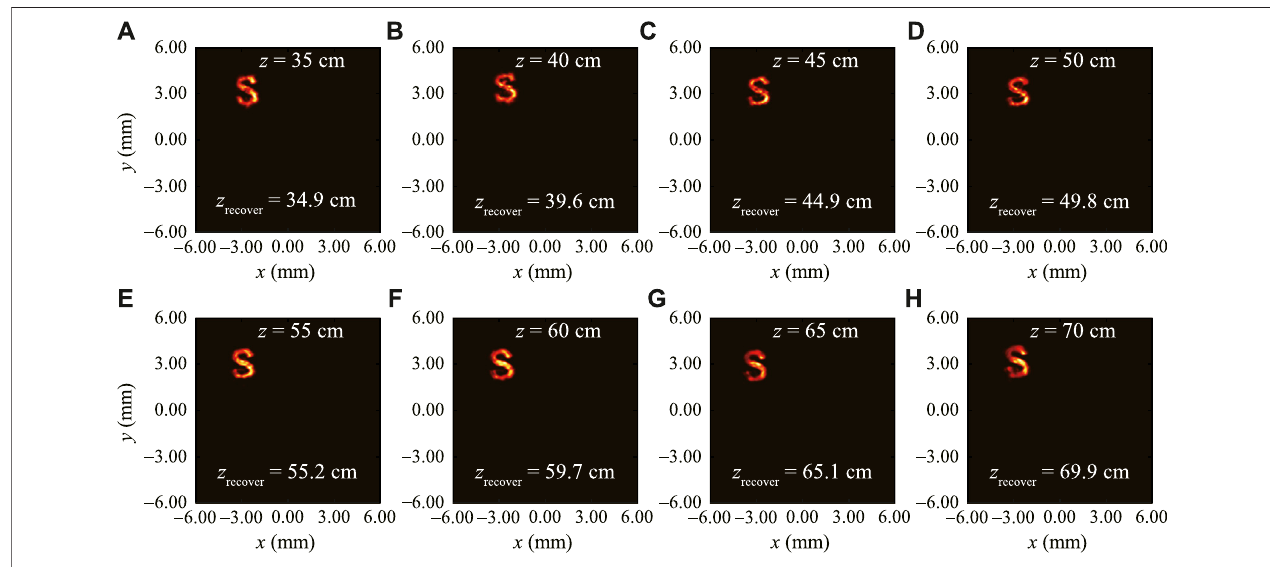
FIGURE 5 | Experimental results of the recovered images with the spatial coherence measurement and the iterative phase retrieval for the case when the image moves along the longitudinal direction. The real distance z and the recovered distance z recover from the RGGD are marked in the fi gures.